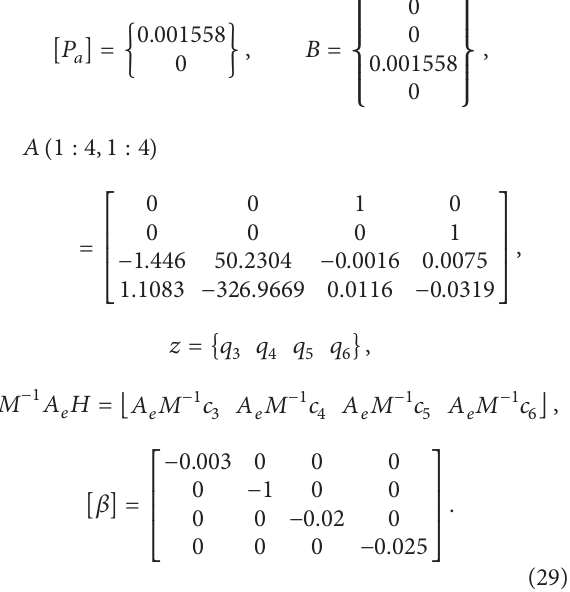
Piezoelectric characteristics are 𝑃 𝑎 = 34.2 , 𝐸 𝑎 = 114 GPa, 𝑞 0 = [1 mm, 1 rad, 1 mm/s, 1 rad/s], 𝑑 31𝑎 = 3×10 −6 , and 𝑟 𝑎 = 10 −3 m (average distance). So,